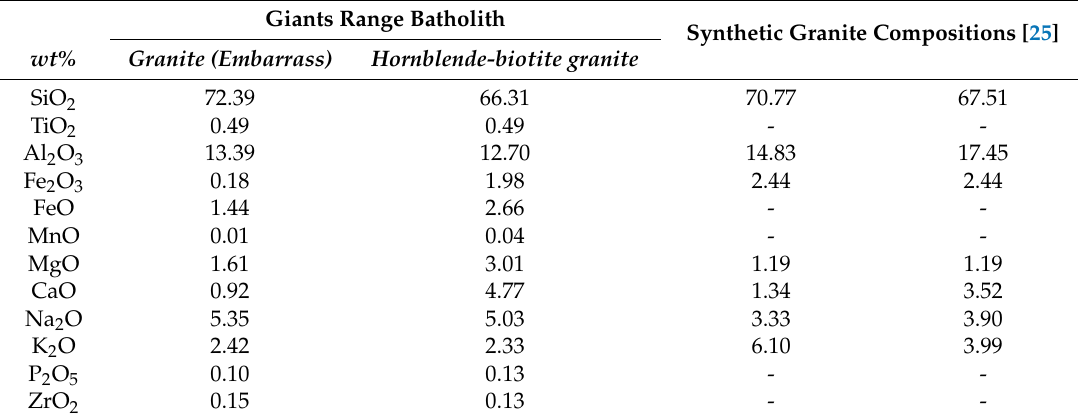
Table 5. Comparison of chemical composition (given in wt%) of the Giants Range batholith and synthetic granites used in the experimental studies [25]. Giants Range Batholith Synthetic Granite Compositions